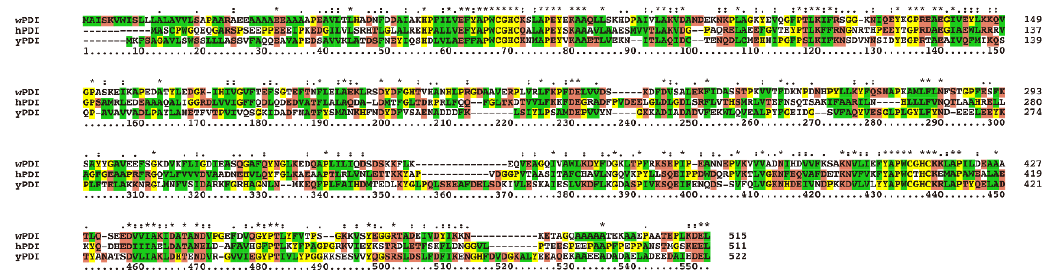
Figure 1. Amino acid sequence alignment of wheat, human, and yeast protein disulfide isomerase (PDI). “*” indicates identical amino acid residues, “ ꞉ ” indicates similar amino acid residues, and “ ꞏ ” indicates less similar amino acid residues. Yellow indicates amino acid residues G, P, C, H, Y; red indicates amino acid residues T, S, N, Q, E, D, K, R; green indicates amino acid residues W, L, V, I, F, A, M, C.